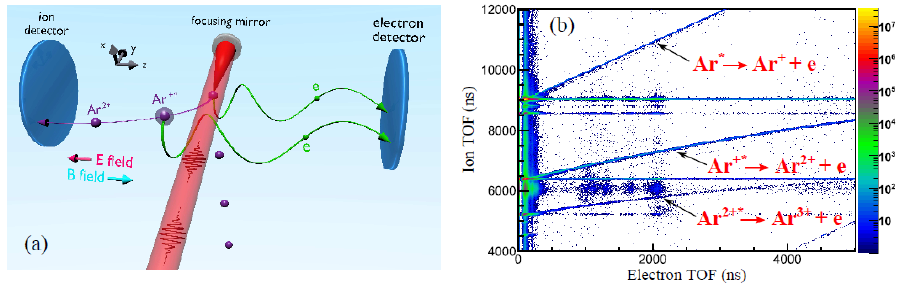
Fig. 1 (a) Schematic view of the experimental setup to achieve the three-body coincidence detection. (b) Measured photo-electron-photo-ion coincidence distribution with the lines representing